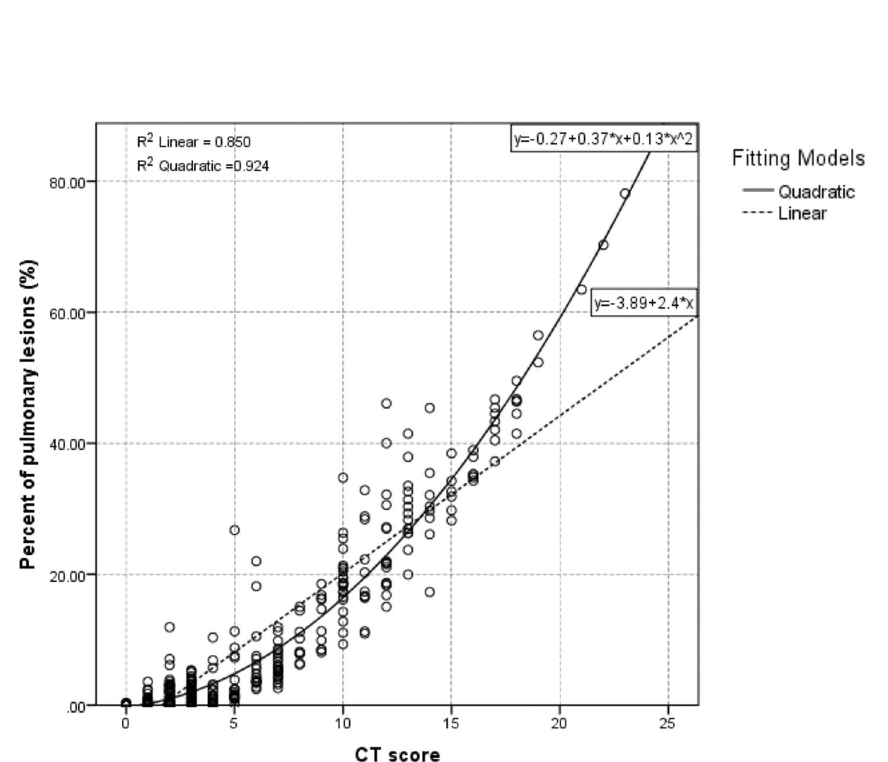
Figure 2. Optimal fitting between CT score and deep learning-based quantification. CT score was estimated using a conventional semi-quantitative method and percent of pulmonary lesions was calculated using deep learning-based assessment. The optimal fitting was a quadratic fitting with the equation 2 of: y = − 0.27 + 0.37 ∗ x + 0.13 ∗ x ( r 2 = 0.924, p < 0.001), which was better than the linear fitting ( y = − 3.89 + 2.4 ∗ x , r 2 = 0.850, p <